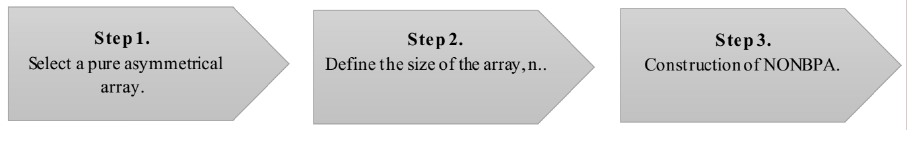
Figure 2. NONBPA